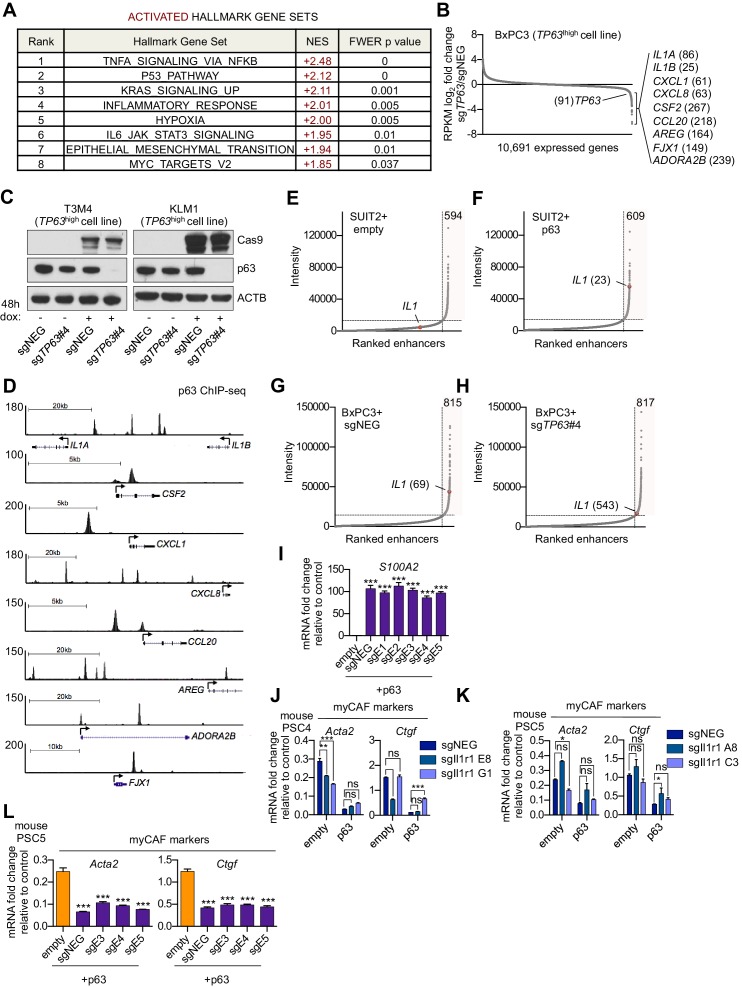
p63 activates enhancer elements and transcription of genes encoding pro-inflammatory cytokines in PDA cells.(A) Table shows evaluation of the indicated Hallmark gene sets by GSEA upon p63 expression in SUIT2 cells. Gene sets are ranked by their NES score and only those with a FWER p value < 0.05 are shown. (B) Scatter plot shows the mean log2 fold change of expressed genes upon p63 knock out in BxPC3 cells. Genes with a mean log2 fold change >1 in this dataset and the SUIT2-p63 dataset (Figure 5C) that are also found in the gene signatures shown in Figure 5A and Figure 5B are highlighted along with the rank. Data are from Somerville et al. (2018). (C) Representative western blot analysis for ACTB, p63 and Cas9 in KLM1 and T3M4 cells lentivirally transduced with a doxycycline-inducible Cas9 vector and the indicated sgRNA. (D) ChIP-seq profiles of p63 in BxPC3 cells surrounding the genes shown in Figure 5D. (E–H) Scatter plots showing enhancers ranked by intensity in SUIT2-empty (E), SUIT2-p63 (F) and BxPC3-Cas9 cells transduced with a control sgRNA (G) or a sgRNA targeting TP63 (H). Shaded box highlights the number of super enhancers identified and the super enhancer associated with the IL1 locus is highlighted along with its rank. (I) RTqPCR analysis for S100A2 in SUIT2-empty or SUIT2-p63 cells infected with dCas9 fused with the KRAB repression domain and the indicated sgRNAs. Mean+ SEM is shown. n = 3. ***p<0.001, **p<0.01, *p<0.05 versus empty control by one-way ANOVA with Dunnett’s test for multiple comparisons. (J–K) Bar charts showing RT-qPCR analysis for the indicated myCAF markers (Acta2, Ctgf) following culture of two mouse PSC lines from which the IL1 receptor was clonally knocked out with CRISPR in Matrigel for four days with conditioned media from SUIT2-empty or SUIT2-p63 cells. (L) Bar charts showing RT-qPCR analysis for myCAF markers (Acta2, Ctgf) following culture of PSCs in Matrigel for four days with the conditioned media harvested from cells shown in Figure 5I. Mean+ SEM is shown. n = 3. ***p<0.001, **p<0.01, *p<0.05 by one-way ANOVA with Dunnett’s test for multiple comparisons.